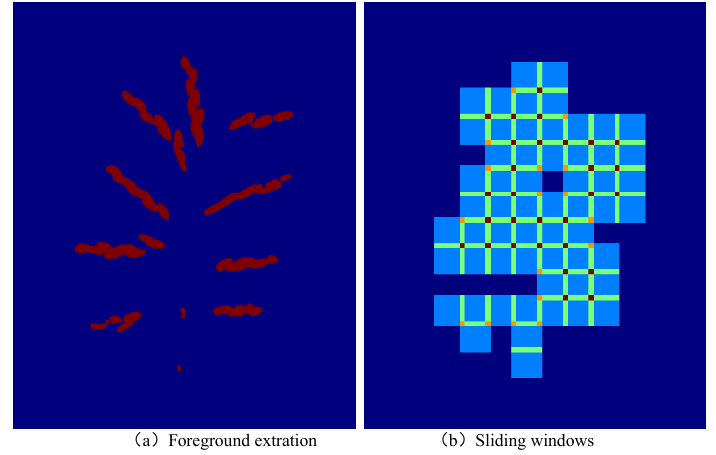
（ a ） Foreground extration Figure 8. Using foreground extraction to remove redundant sliding windows. Figure 8. Using foreground extraction to remove redundant sliding windows. The result of the grain counting algorithm can be visualized by Figure